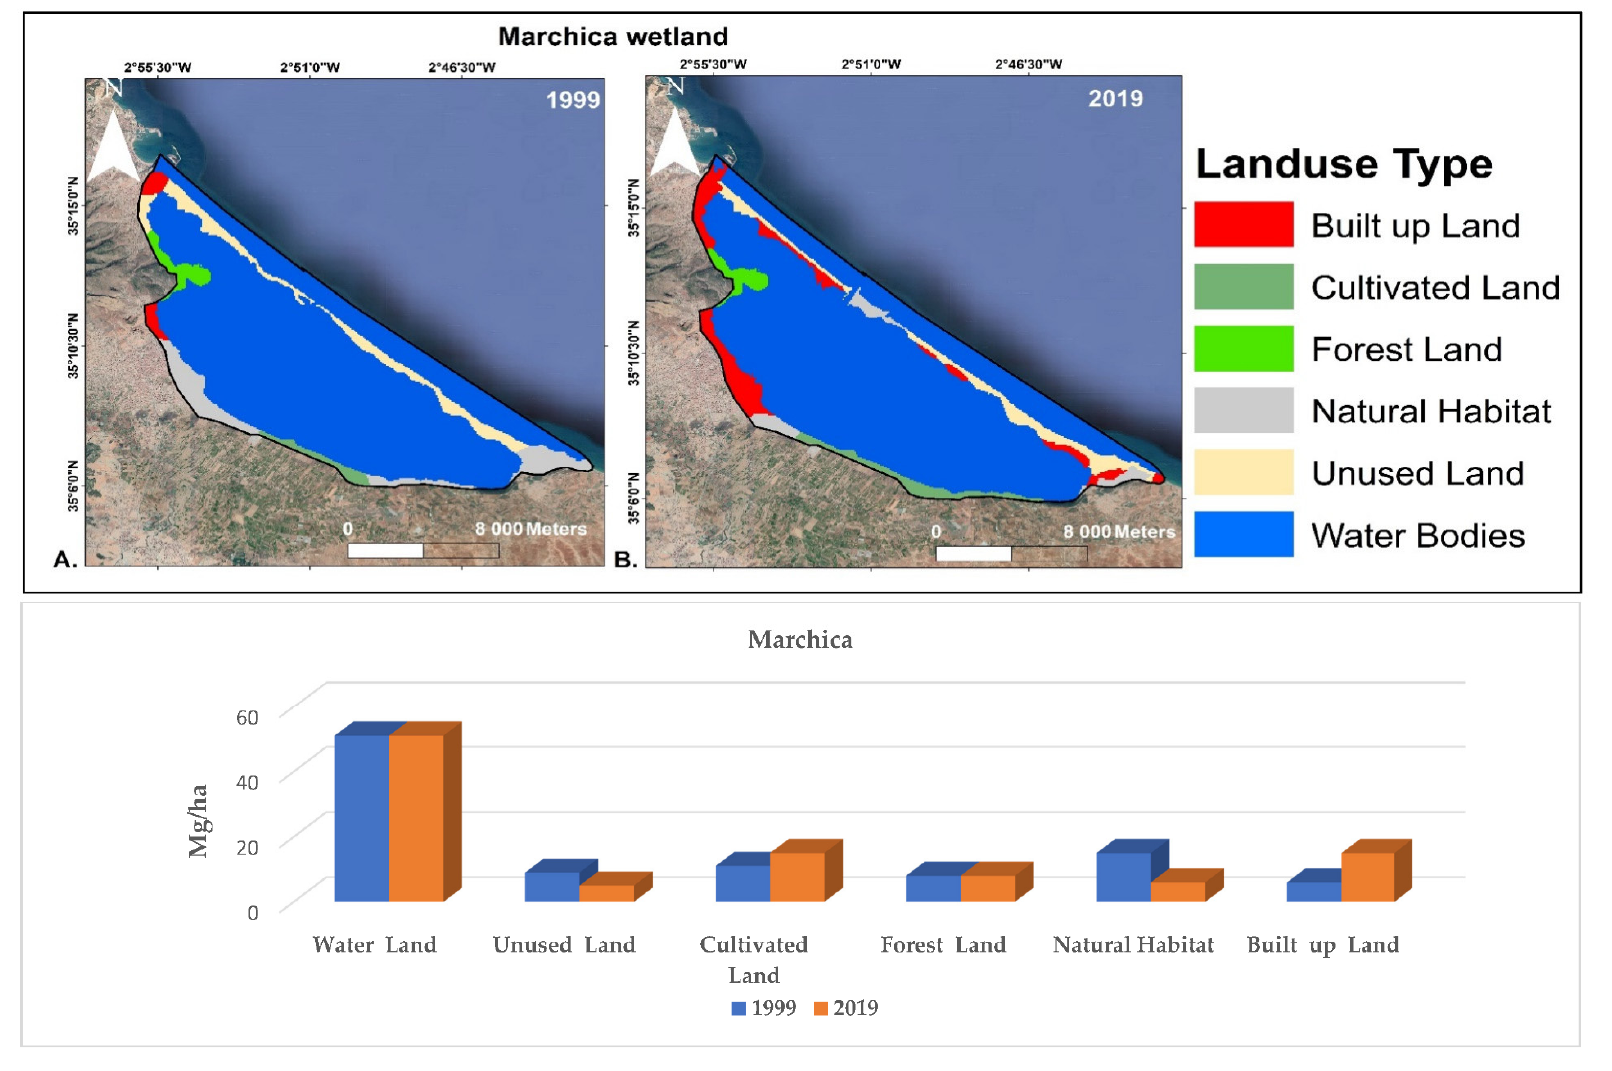
Figure 5. Maps and percentages of LULC changes in Marchica between 1999 and 2019: ( A ) LULC change of 1999; ( B ) LULC change of 2019 .